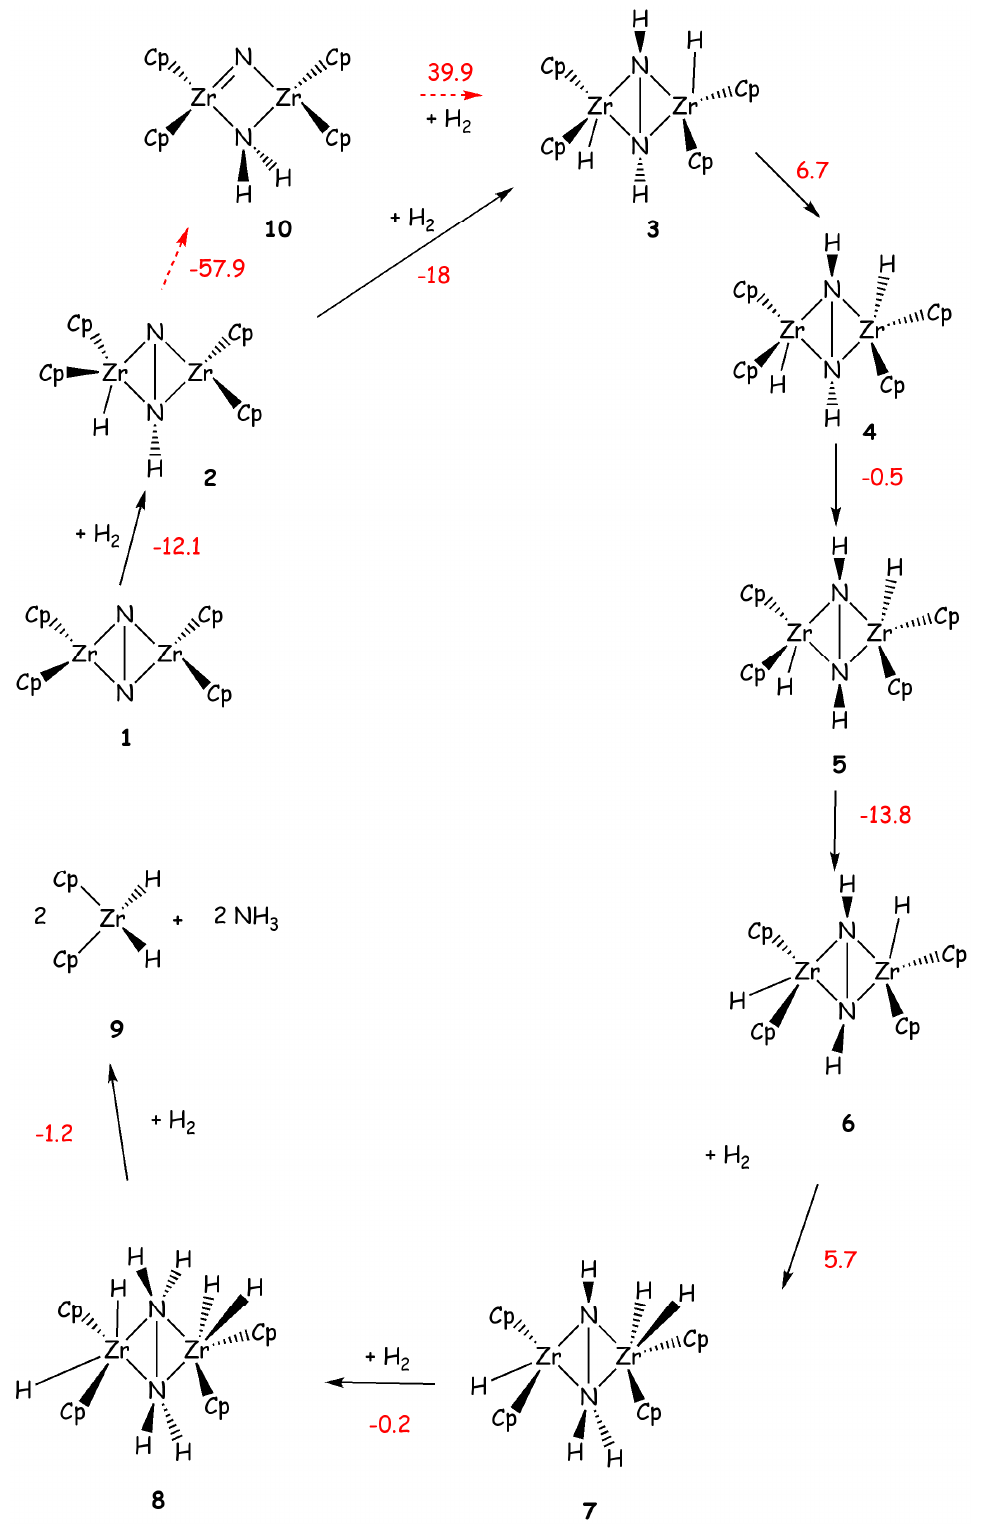
Scheme 5. N hydrogenation performed by a model of Chirik complex. Reaction energies 2 (kcal/mol) are shown in red. Reaction energies, calculated with respect to 1 , for the formation of 6 , 9 and 10 , using as a model the real Chirik complex, are -35.3, -44.2 and - 56.7 kcal/mol,